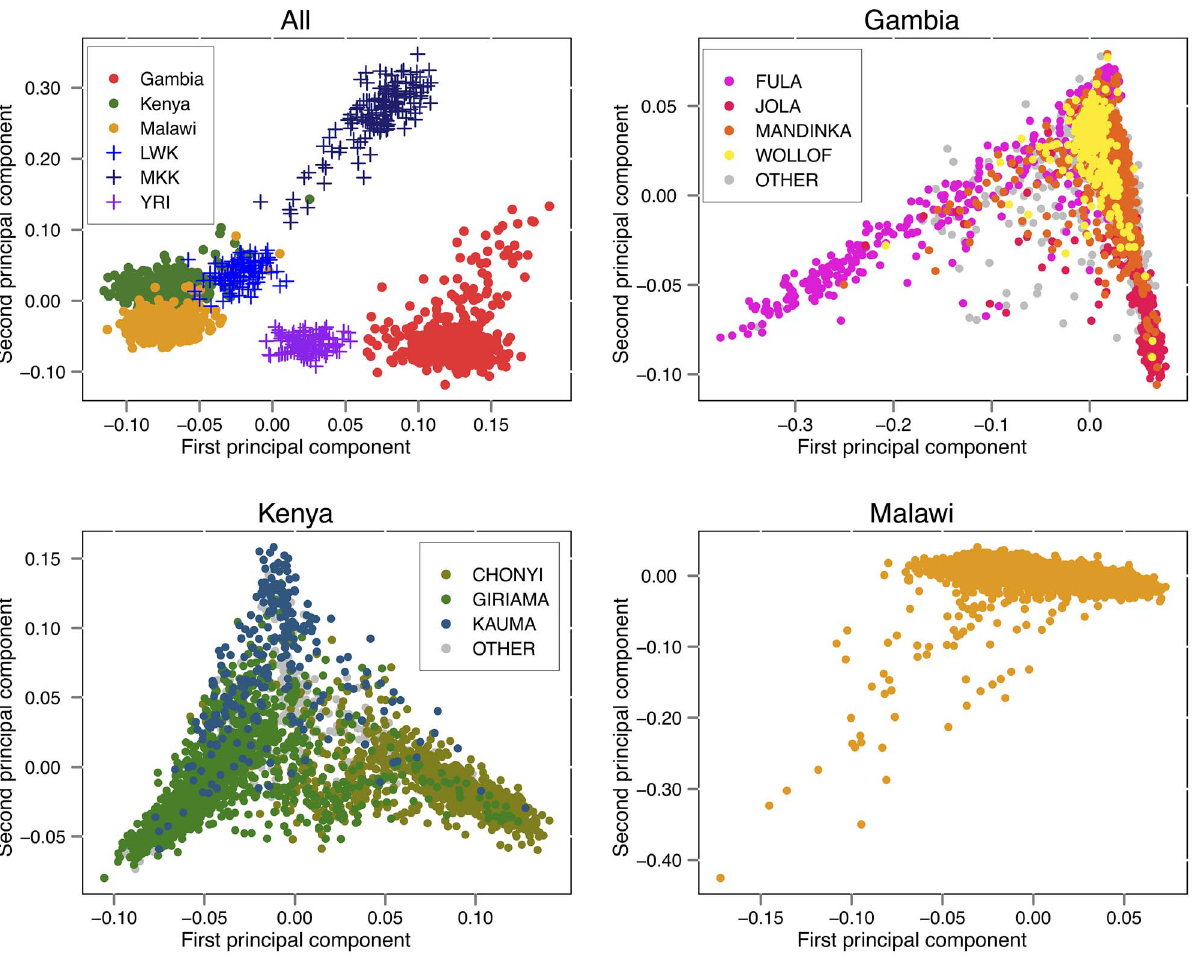
Figure 2. Principle components analysis. Top left: principal components analysis (PCA) of the African populations from Hapmap 3 (LWK=Luhya in Webuye, Kenya, 90 individuals; MKK=Maasai in Kinyawa, Kenya, 143 individuals; YRI=Yoruba in Ibadan, Nigeria, 113 individuals) with 500 randomly selected control samples from each of the three study cohorts. Top right, bottom left, bottom right: PCA of all non-excluded samples in each study cohort, coloured by reported ethnic group. Ethnic group is shown as ‘‘OTHER’’ for groups constituting less than 5% of individuals in the cohort, or where the ethnic group was unreported.